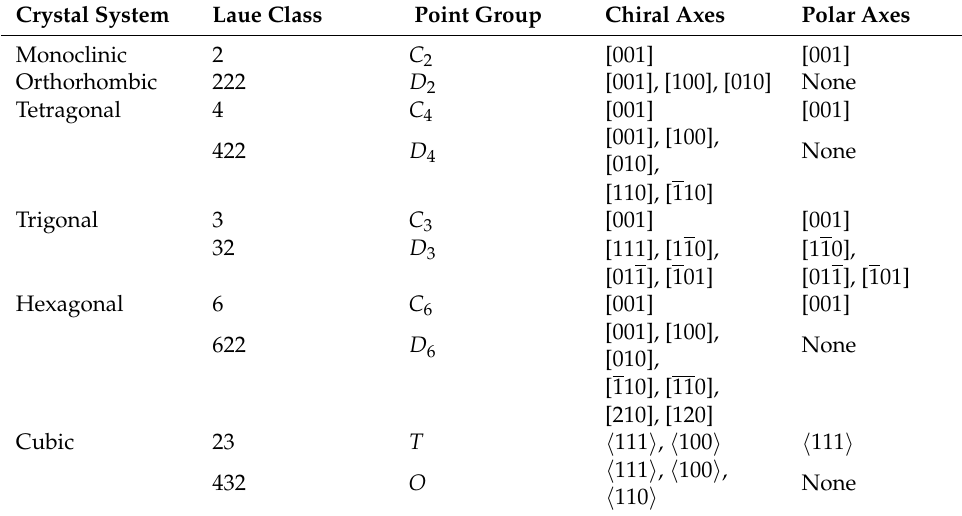
Table 4. Chiral and polar axes of the Sohncke groups. c is assumed to be a unique axis for the monoclinic system. The rhombohedral axes are assumed for trigonal systems (e.g., 32), for hexagonal setting Laue class 321 must be distinguished from 312. Single axes are denoted by [], groups of axes are denoted by (cid:104) (cid:105) .